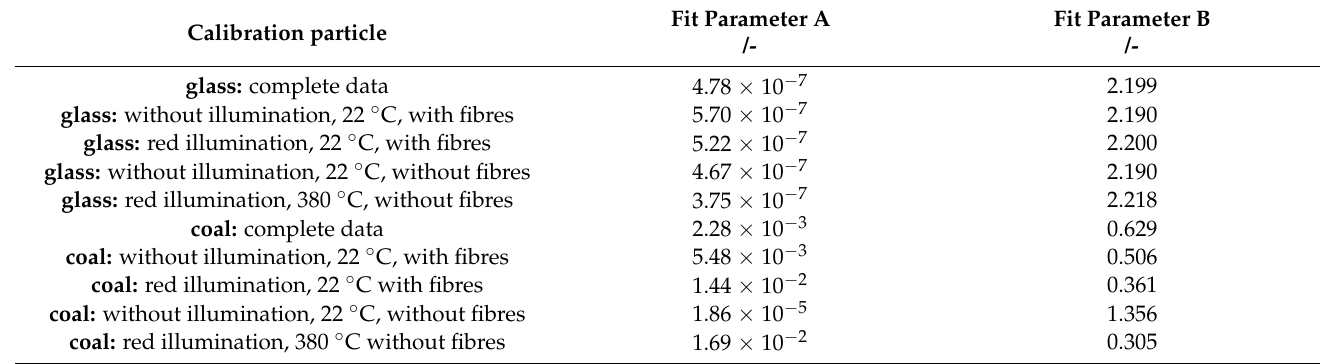
Table 1. Fit Parameters for the Calibration Curves of the LLS-OPC.